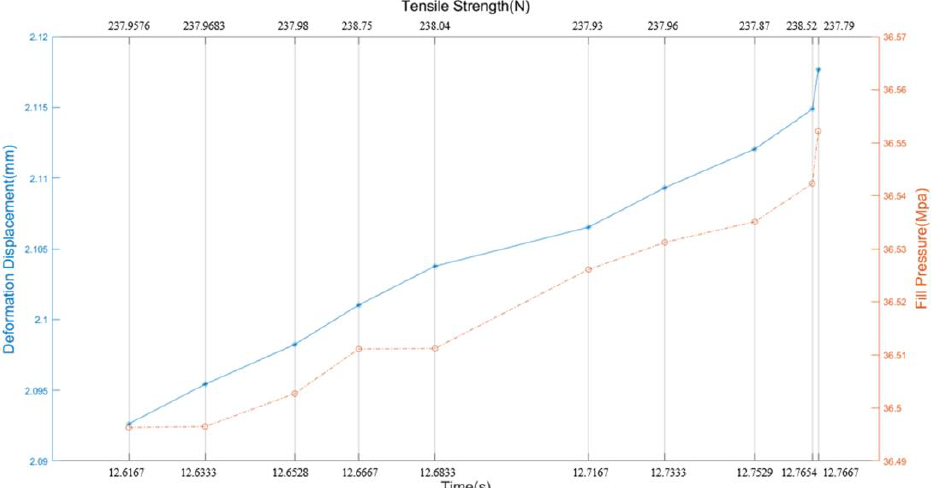
Figure 10. Batch control “deformation displacement” shows that the deformation displacement is close to the variation of the filling pressure value, both of which are helpful to improve the “tensile stress data”.